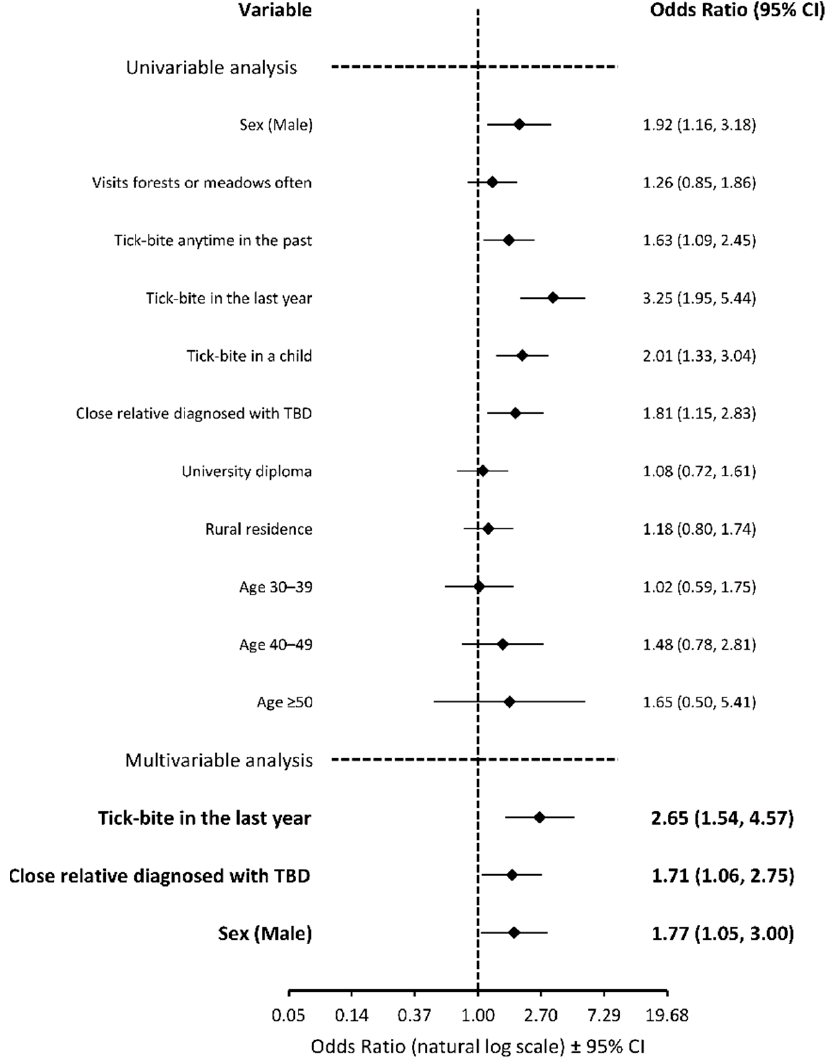
Figure 1. Binominal logistic regression analysis of variables associated with the odds of receiving or declaration to receive the TBE vaccine. The age-related odds were calculated with reference to age under 30 years. Abbreviations: TBD, tick-borne disease.